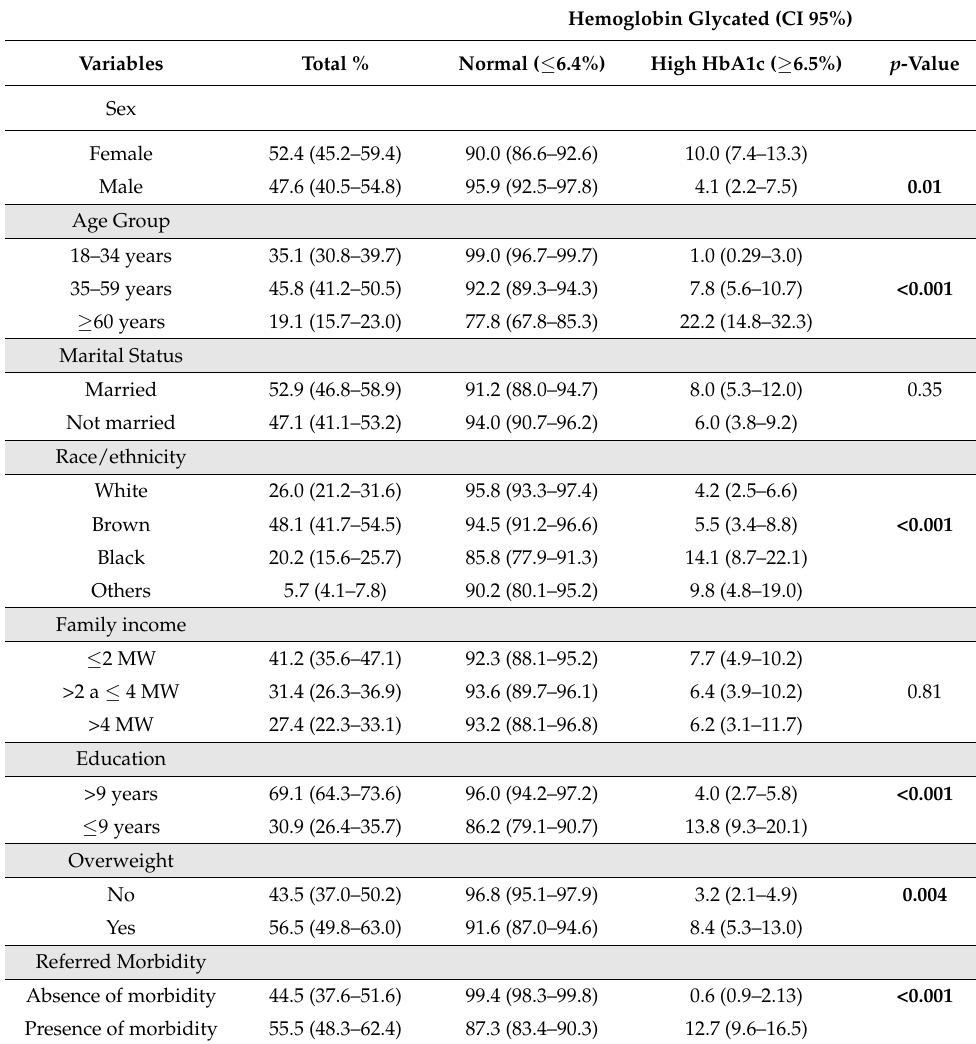
Table 1. Sociodemographic characteristics according to serum concentrations of glycated hemoglobin (HbA1c). COVID-Inconfidentes, October to December